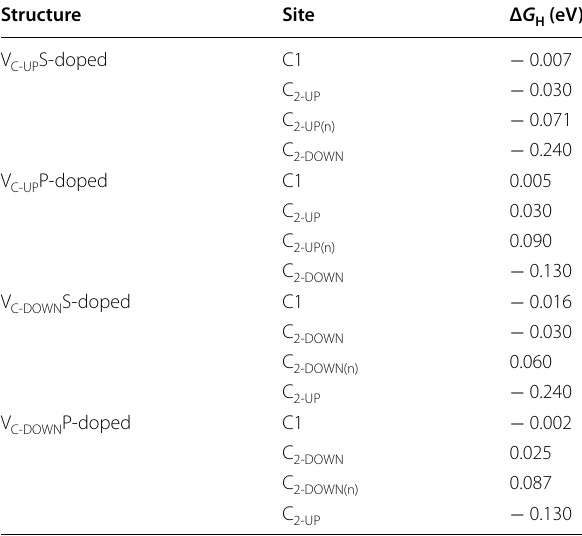
values of C2 vacancies and S-, H